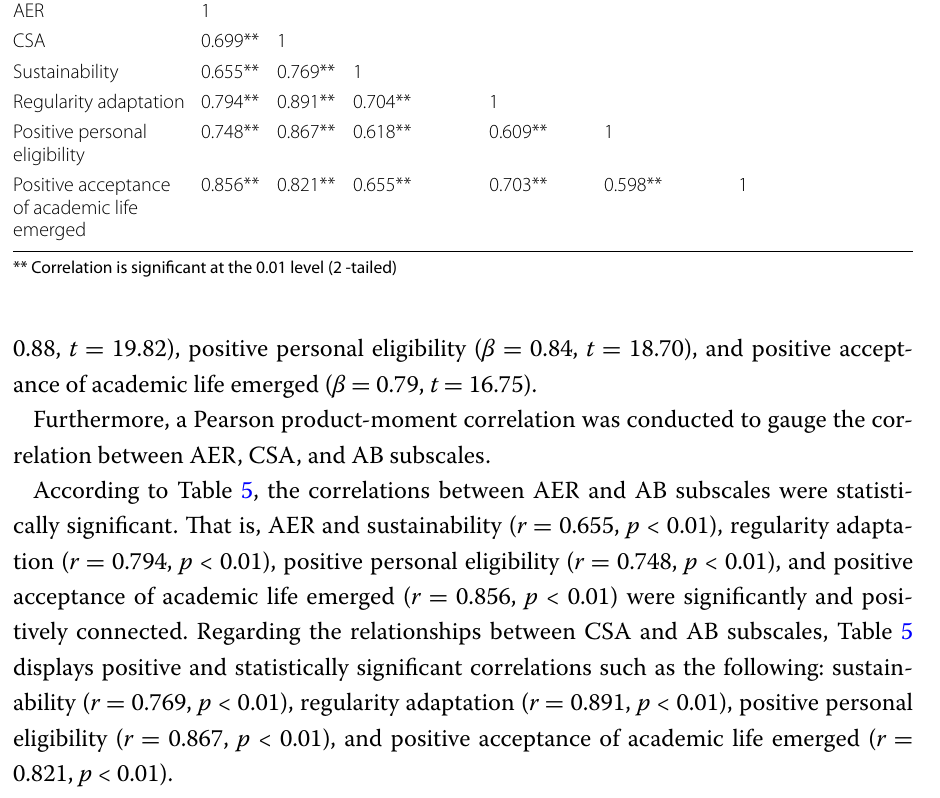
Table 5 The correlation coefficients between AER, CSA, and AB subscales